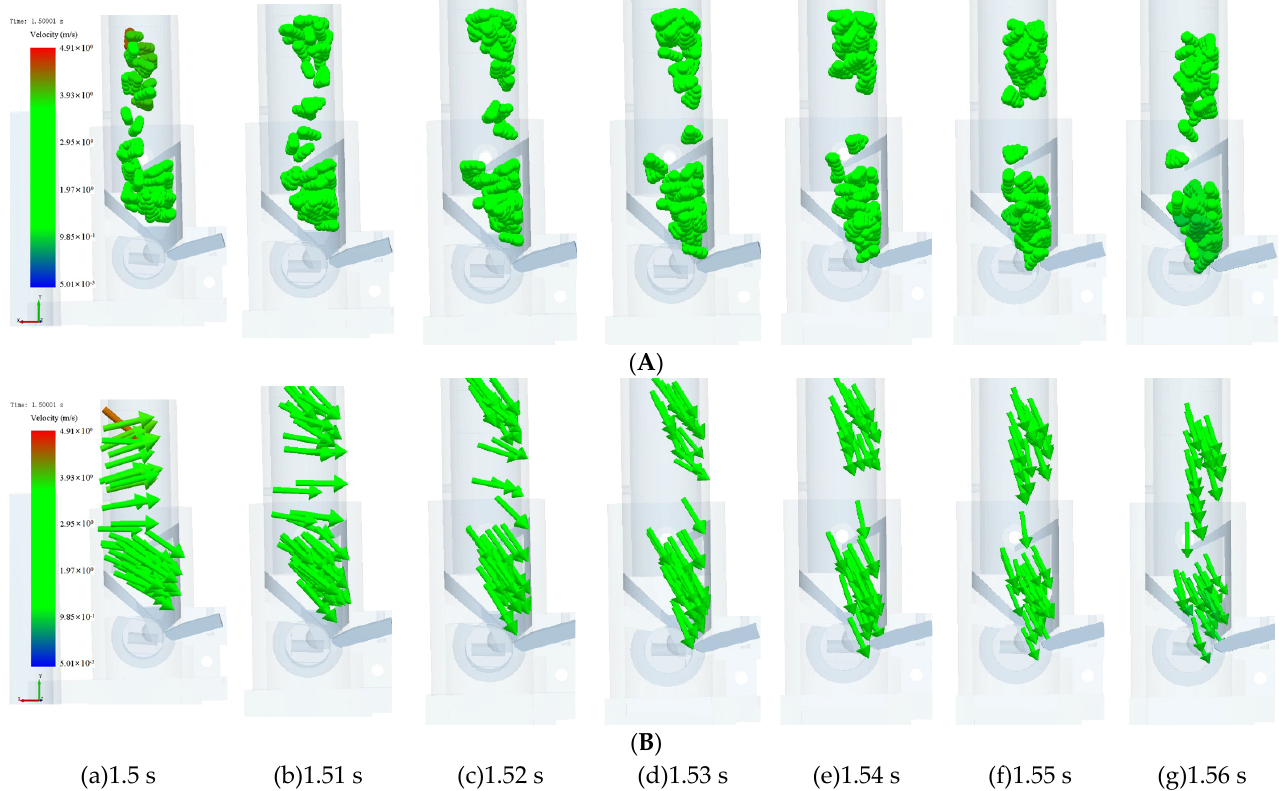
Figure 18. Movement process of maize in the seed tube with the added inverted hook. ( A ) Default display. ( B ) Vector display.